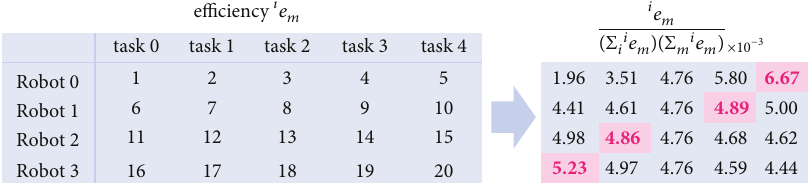
Figure 19: Example of allocation based on the proposed method.